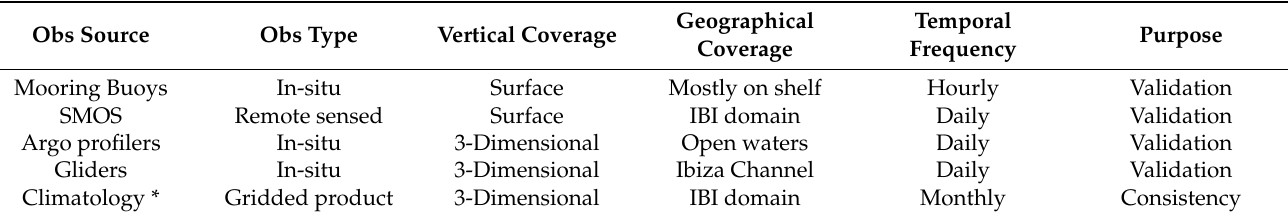
Table 2. Summary of observational (Obs) platforms used in NARVAL (North Atlantic Regional VALidation) toolbox to validate IBI model salinity (* the climatology used is the World Ocean Atlas (WOA)